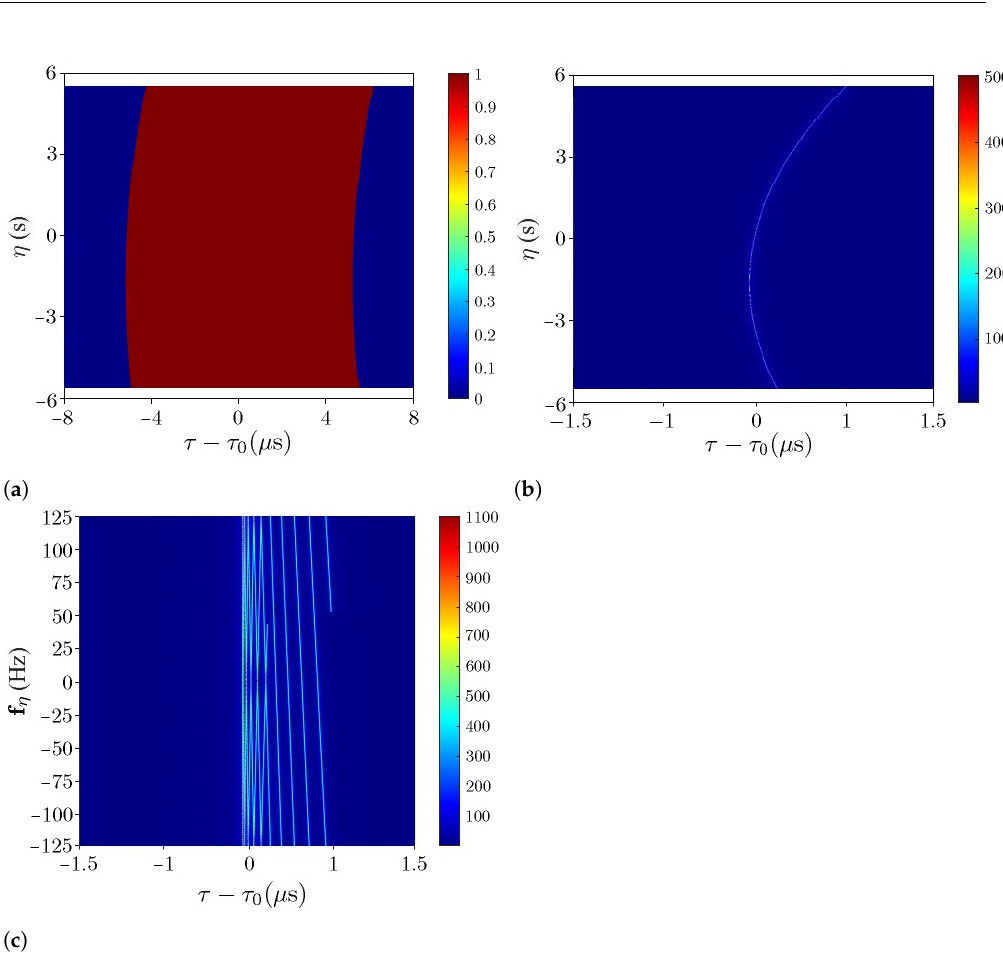
( τ , η ) , received signal 21 = 2 R 0 / c 0 0